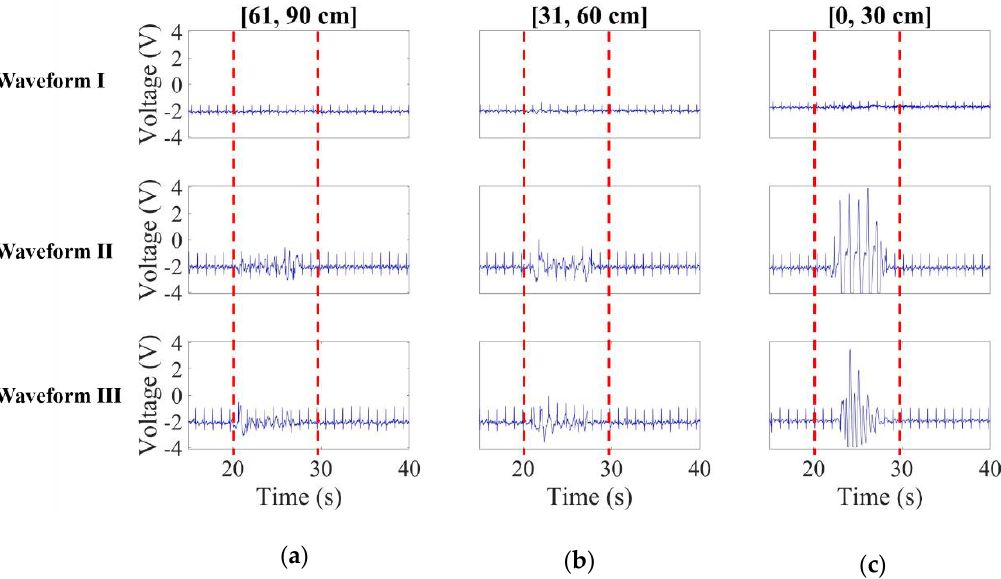
Figure 11. CECG waveform comparison when the simulated noise source approaches the subject at 30 cm/s over intervals ( a ) [61, 90 cm], ( b ) [31, 60 cm] and ( c ) [0, 30 cm].